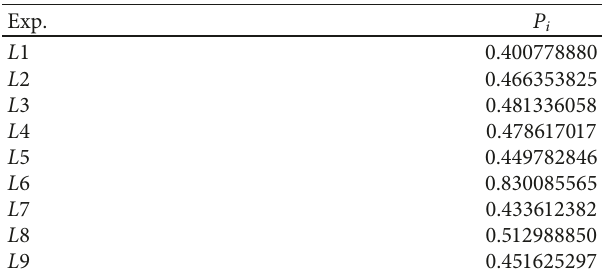
Table 19: Relative performance closeness to the ideal solu. B − i ) and ideal ( i